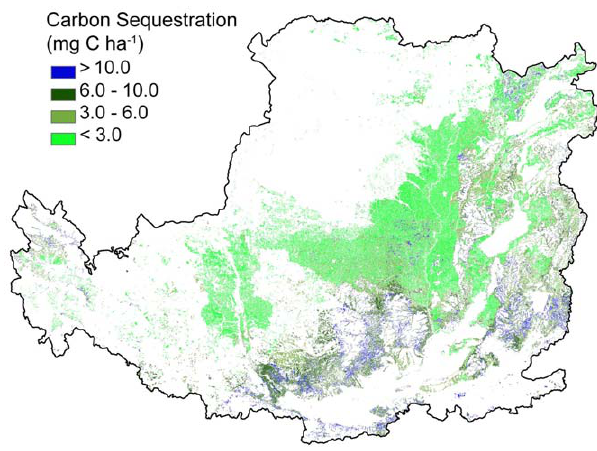
Figure 7. The spatial distribution of carbon sequestration.